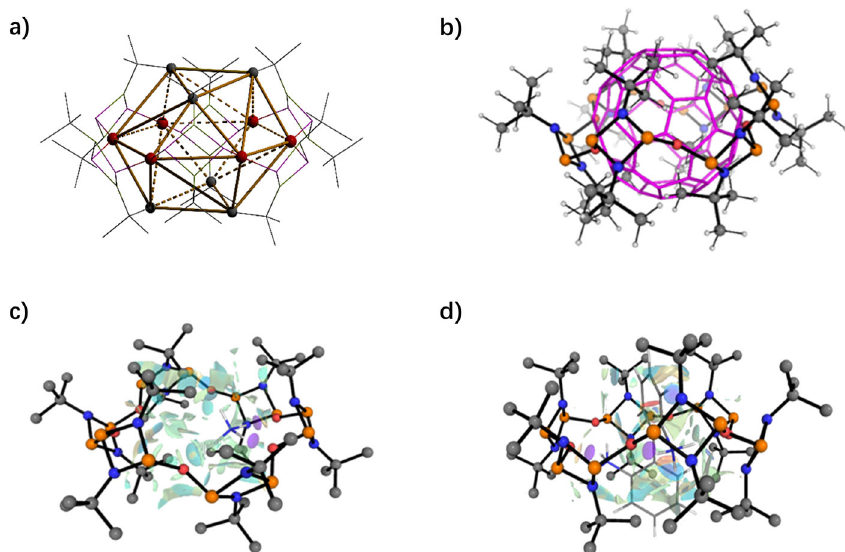
Fig. 6 Cavity size assessment and non-covalent interactions present in 7. Side view of the internal volume de fi ned by an icosahedron determined by the oxygen atoms and the tert -butyl groups in compound 7 ( a ). Graphical comparison of the cavity sizes of 7 and C60. The geometry optimisation of 7 and C60 was performed at the ω -B91xD/6 – 31 G(d,p) level of theory. The C60 backbone is represented as wires ( b ). Non-Covalent Interaction (NCI) computed at ω -B91xD/6-31G(d,p) for the host-guest adducts of 7 with then ammonium ( c ) and 1,1 ′ -biphenyl-2,2 ′ -diammonium ( d